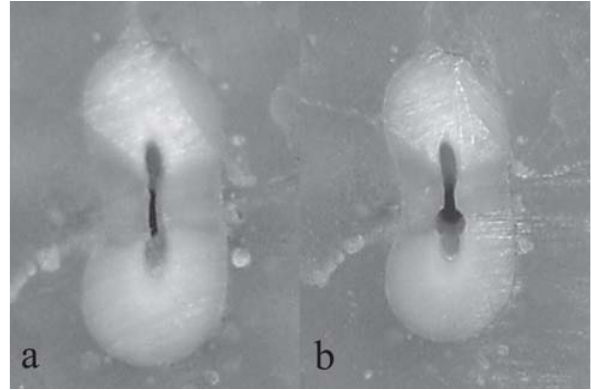
FIGURE 2- Middle third before (a) and after (b) preparation with RaCe system (Score 2)